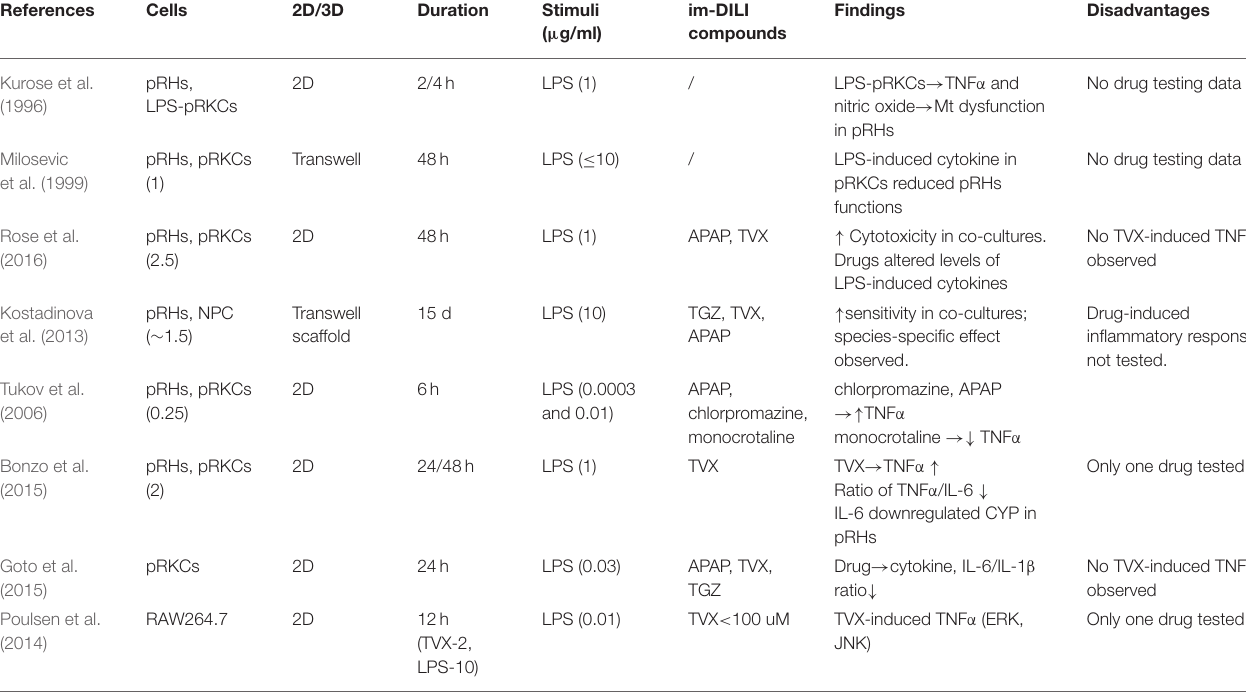
TABLE 2 | Animal in vitro liver co-culture models comprising of hepatocytes and immune